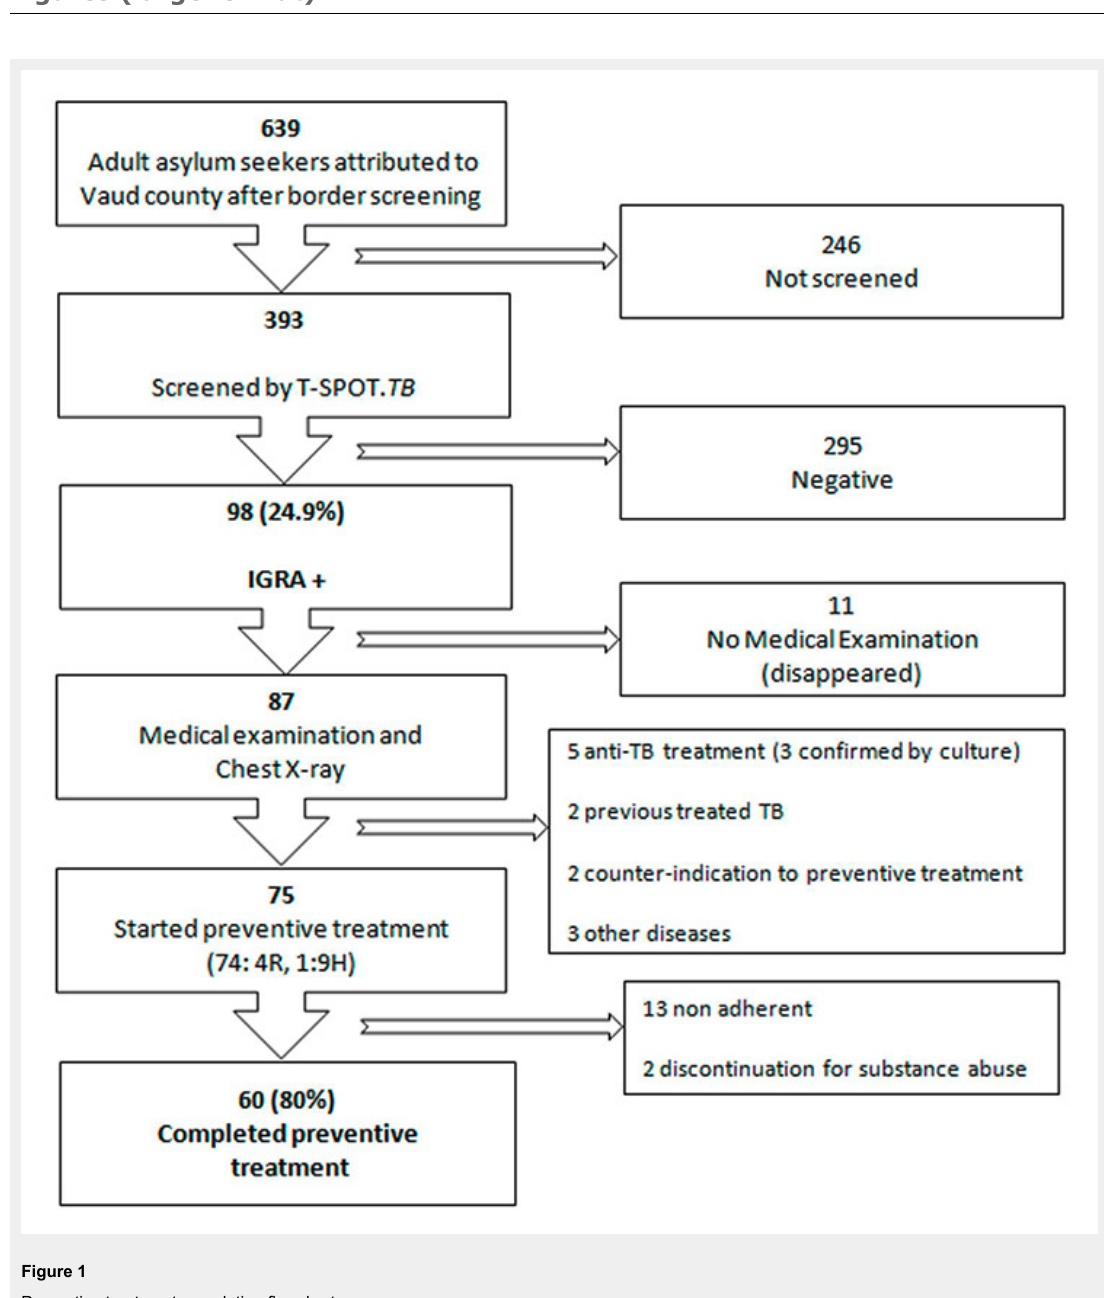
Figure 1 Preventive treatment completion flowchart. * IGRA = Interferon Gamma Release